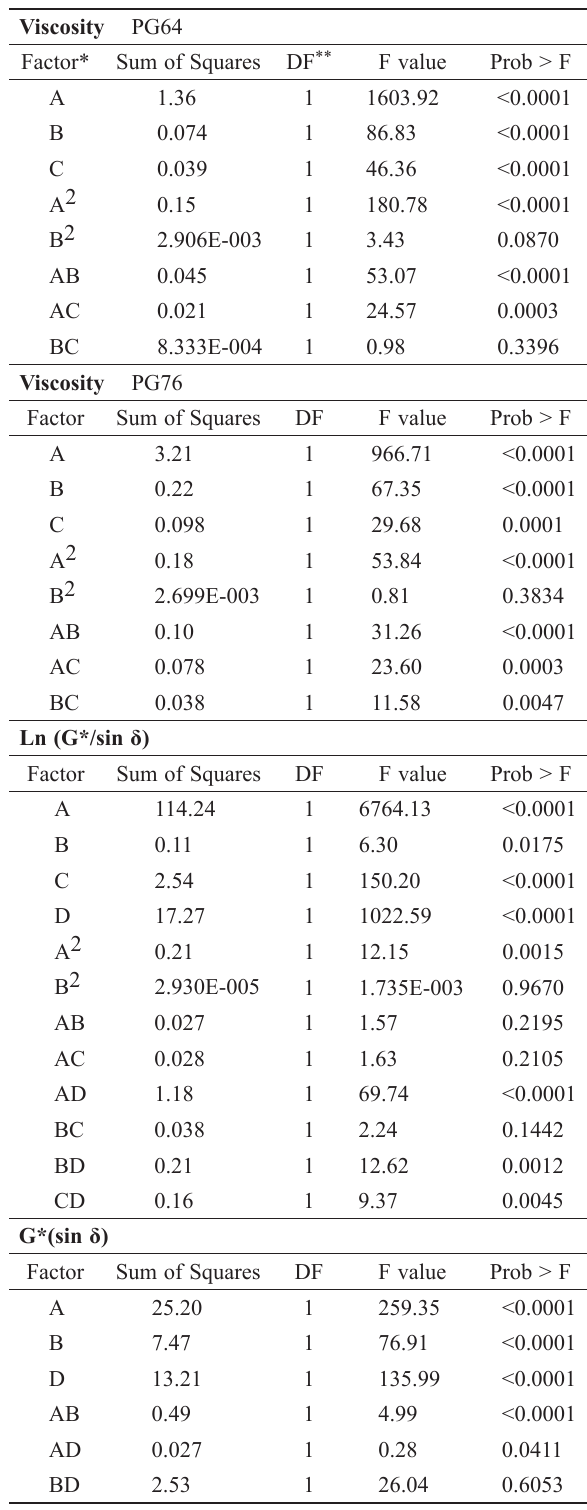
Table 7. Analysis of variance for viscosity, G*/sin δ and G*sin